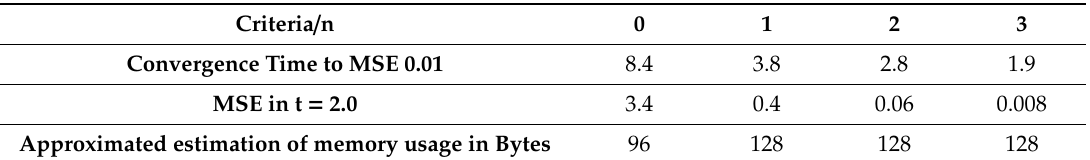
Table 3. Comparison of performance of time varying matrix inversion with change of parameter n of Equation (24) or Equation (31). Please note n = 0 is ZNN